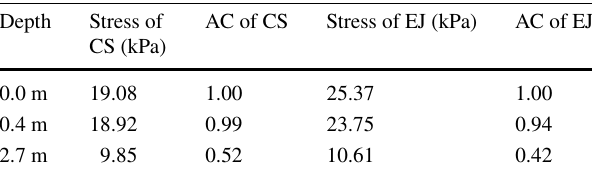
Table 4 Stress attenuation in depth for continuous and discontinuous structures